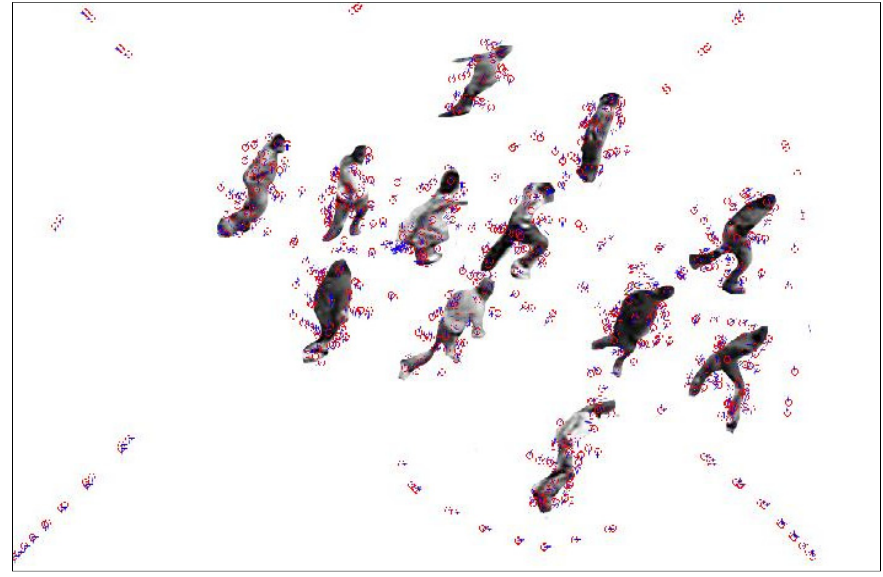
Figure 8. The graphical visualization of force flow matrix features of the EBP system.